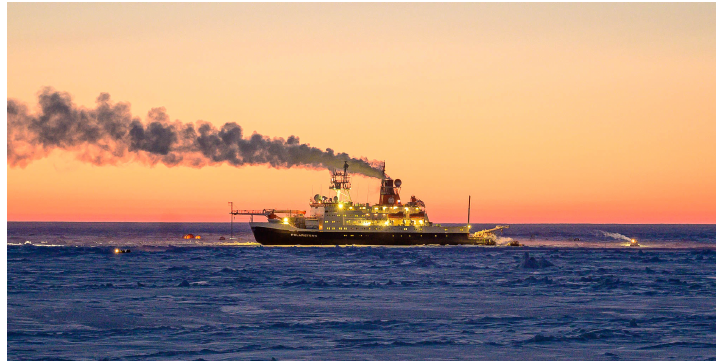
Figure A5. A situation when the wind was coming from the stack’s direction and the exhaust plume went directly over the Swiss Container , but due to the surface inversion no pollution spikes were measured in the Swiss Container . The container was located at the bow of the ship, below the crane (left-hand side in this picture). Photo credit: Ivo